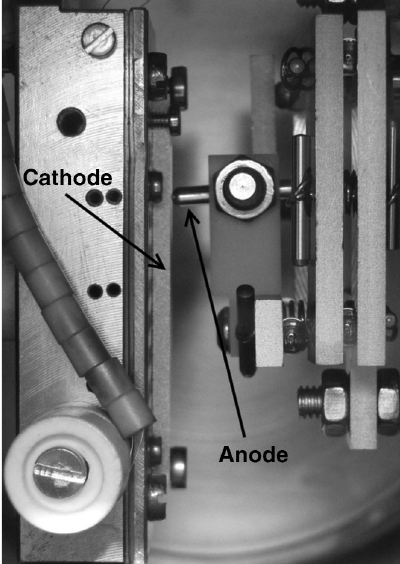
FIG. 2. Picture of the experimental setup. The anode (cylin- drical, diameter 2.3 mm, preprocessed) is seen on the right, the cathode (planar) on the left. The typical gap distance is (cid:4) 20 (cid:2) m . The discharge between the anode and the grounded cathode occurs in ultrahigh vacuum, in the range (cid:2) 2 (cid:5) 10 (cid:3) 11 – 10 (cid:3) 9 mbar , in order to match the vacuum conditions required for